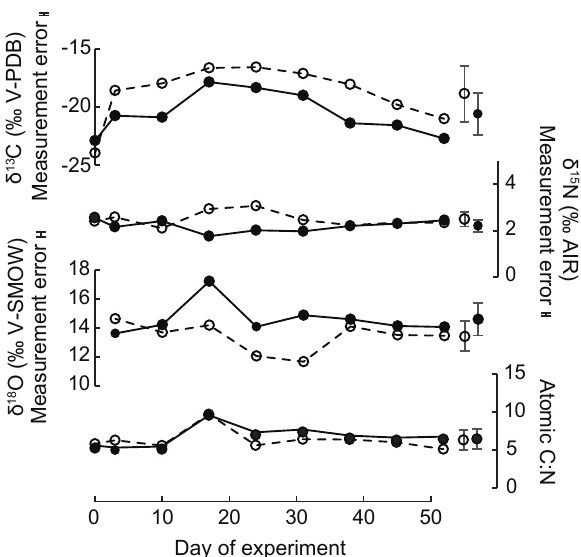
Figure 1. δ 13 C, δ 15 N and δ 18 O values and atomic C:N ratios of the algae harvested from both chemostats during the experiment. Open circles with dashed line represent the standard algae, and the closed circles with solid line represent the algae that were cultured on a medium with the addition of 13 C-depleted bicarbonate. The data points and error bars on the right side of the plots indicate average values and 1 SD, respectively.